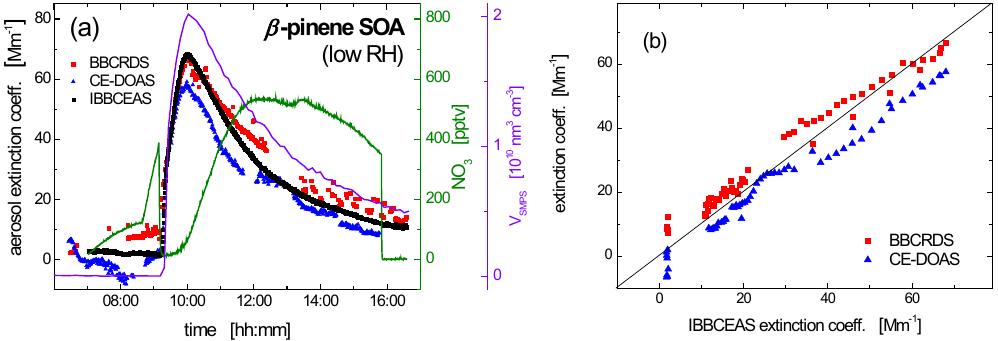
Fig. 3. (a) Time profile of the aerosol extinction coefficient following NO 3 oxidation of β -pinene under dry conditions (20 June). Changes to the chamber composition occurred at 06:27–06:37 (80ppbv NO 2 ), 06:50 (15ppbv O 3 ), 08:40 (80ppbv O 3 ), and 09:09 (15ppbv β -pinene). The NO 3 concentration (green) and aerosol volume (violet) are also shown. (b) correlation plots of the aerosol extinction coefficients retrieved by the BBCRDS and CE-DOAS instruments against those from the IBBCEAS measurements. The 1:1 line is shown as a solid line.